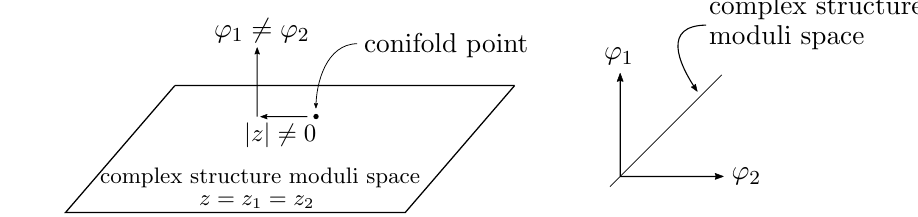
Figure 4 . Illustration of the z 1 - z 2 deformation space. The complex structure moduli space is the subspace z 1 = z 2 . We only consider deformations away from z 1 = z 2 outside the conifold point.